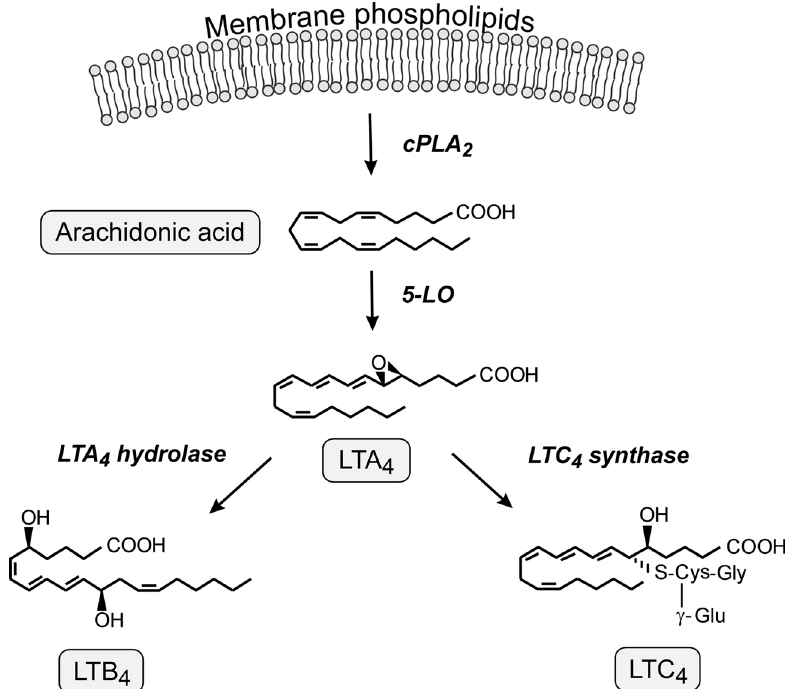
FIGURE 1. Biosynthesis of leukotrienes. Arachidonic acid is liberated from membrane phospholipids by cytosolic phospholipase A 2 (cPLA 2 ). The fatty acid is transformed by 5-lipoxygenase (5-LO) into the unstable epoxide LTA 4 . This transient intermediate is the substrate for LTA 4 hydrolase and LTC 4 synthase to produce LTB 4 and LTC 4 ,